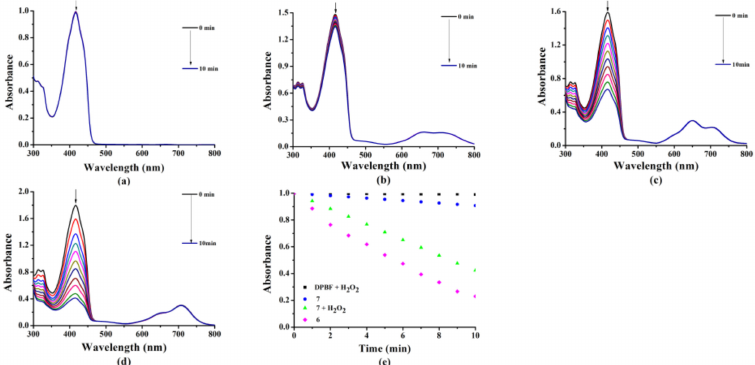
Figure 7. The absorption spectra of DPBF (0.1 µ M) after different durations of 670 nm laser irradiation ( a ) only DPBF in the presence of H2O2; ( b ) with compound 7 (5 µ M); ( c ) with compound 7 (5 µ M) in the presence of H2O2 (250 µ M); ( d ) compound 6 (5 µ M); ( e ) comparison of the degradation rates of 1,3-diphenylisobenzofuran (DPBF) as monitored by the decrease in absorbance at 415 nm with irradiation time; the experiments are carried out in solution (PBS/DMSO = 4:1, v / v ; 10 mM, pH = 7.4).